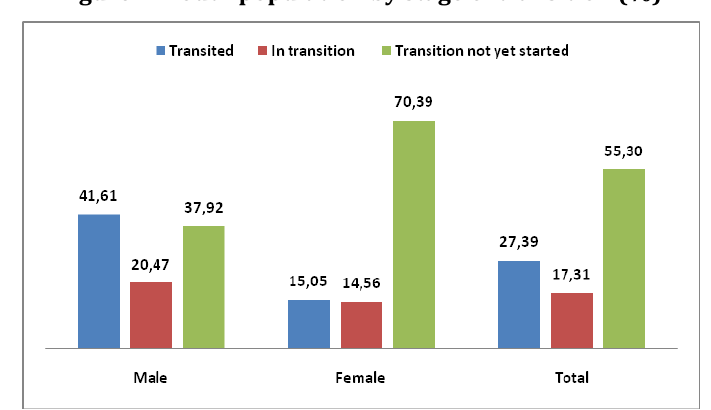
Figure 1: Youth population by stage of transition (%)